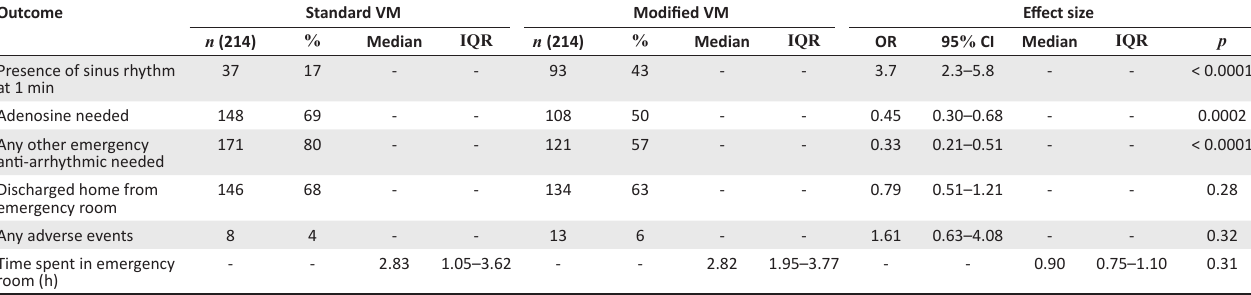
TABLE 1: The REVERT trial – Primary and secondary outcomes. Outcome Standard VM Modified